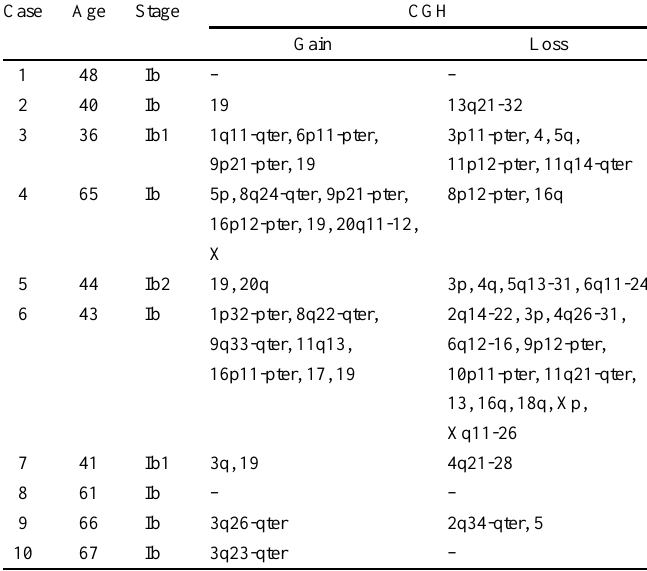
Clinical data and comparative genomic hybridization results from 10 patients with cervical squamous cell